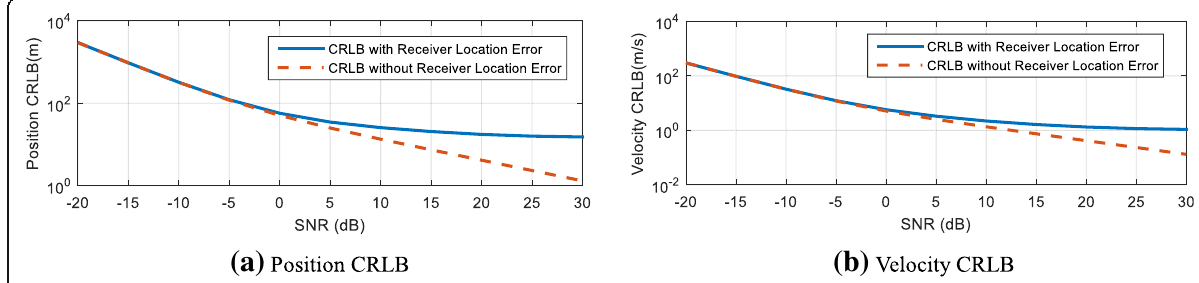
Fig. 2 CRLB comparison versus SNR when σ s = 10 0.5 m. a Position CRLB. b Velocity CRLB